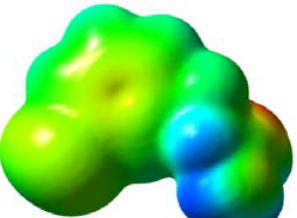
Fig.7: Electrostatic potential surfaces of